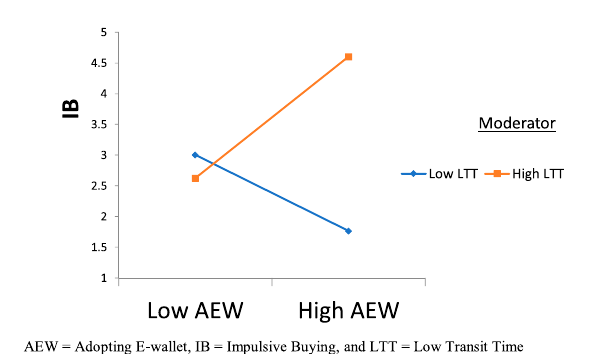
FIGURE 4 Moderation LDC - > IB. AEW, Adopting E-wallet; IB, Impulsive Buying, and LDC, Low Distribution Charges.